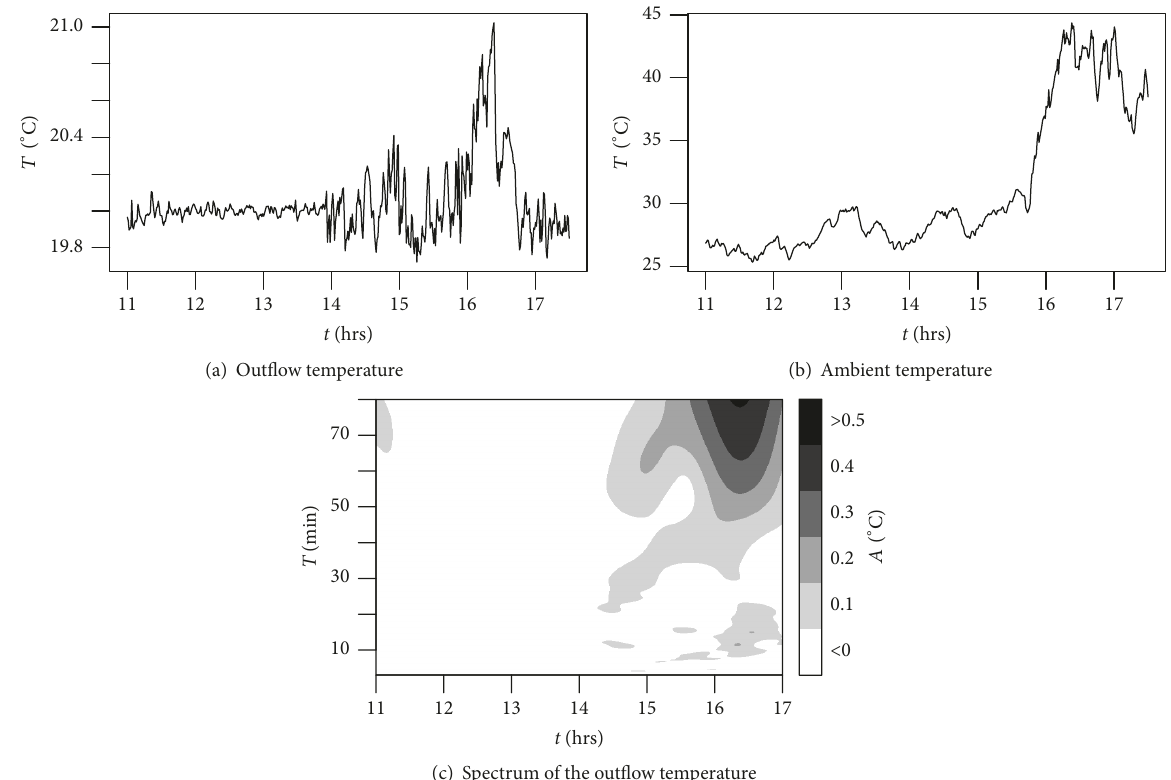
Figure 15: Outflow temperature of a 300 kW cooling system. Panel (a) shows the performance of the outflow temperature. At about 4 p.m., the system reaches its control limits, because the ambient temperature (b) exceeds significantly the set-point (20 ∘ C) of the outflow temperature. The high eigenfrequencies of the hydraulic system become visible from about 2:30 p.m.